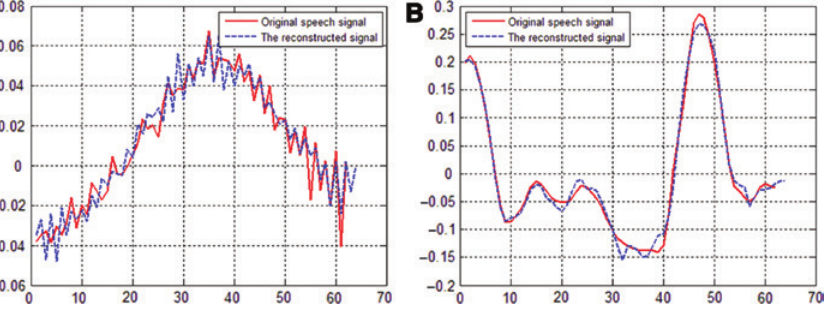
for Two Different Energy Level Frames. 50